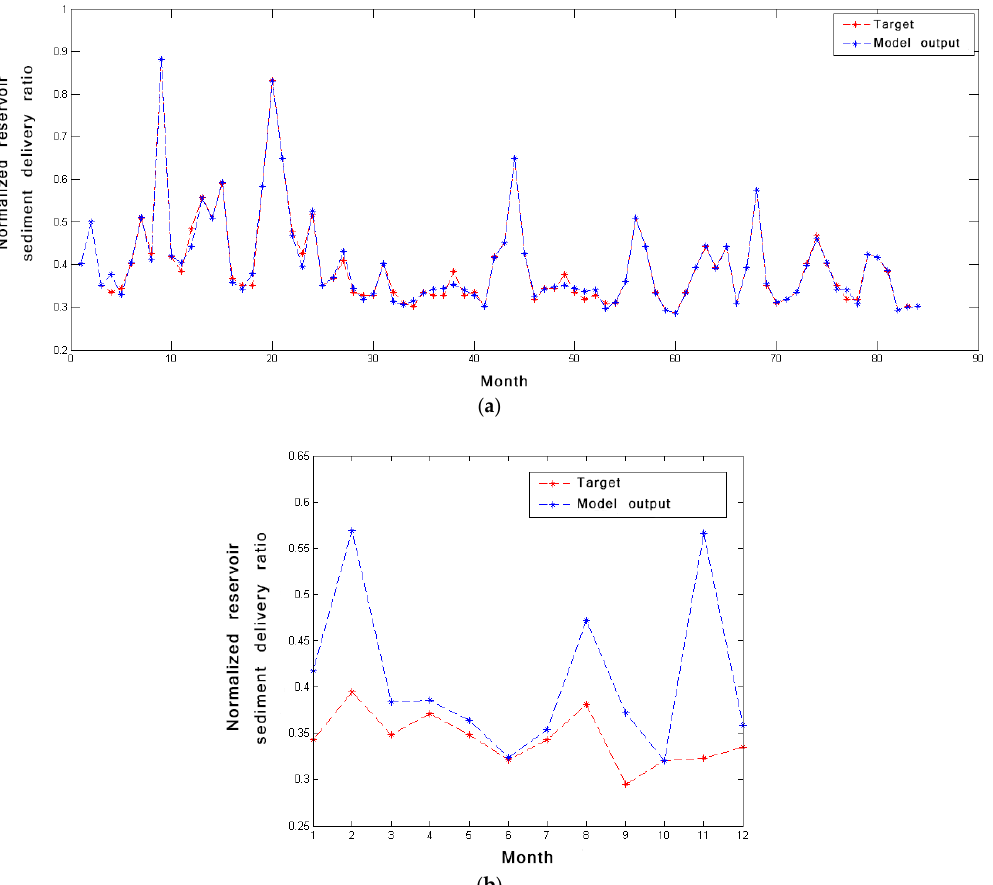
Figure 4. ( a ) simulation result and ( b ) prediction result of the BP ‐ ANN model.